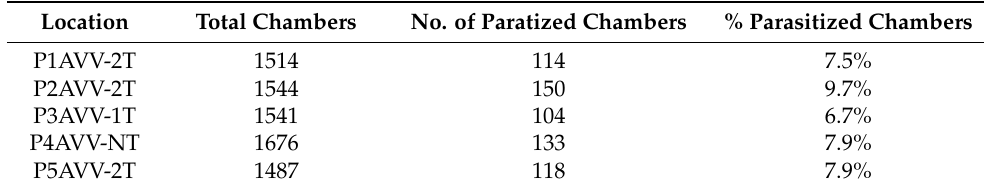
Table 5. Total number of chambers, number of parasitized chambers and parasitism rate in 5 chestnut orchards in Minho (P1 to P5) located in Arcos de Valdevez (AVV) and Ponte de Lima (PL), with one (1T), two (2T) or no treatment (NT) of T. sinensis in 2018. Location Total Chambers No. of Paratized Chambers % Parasitized Chambers